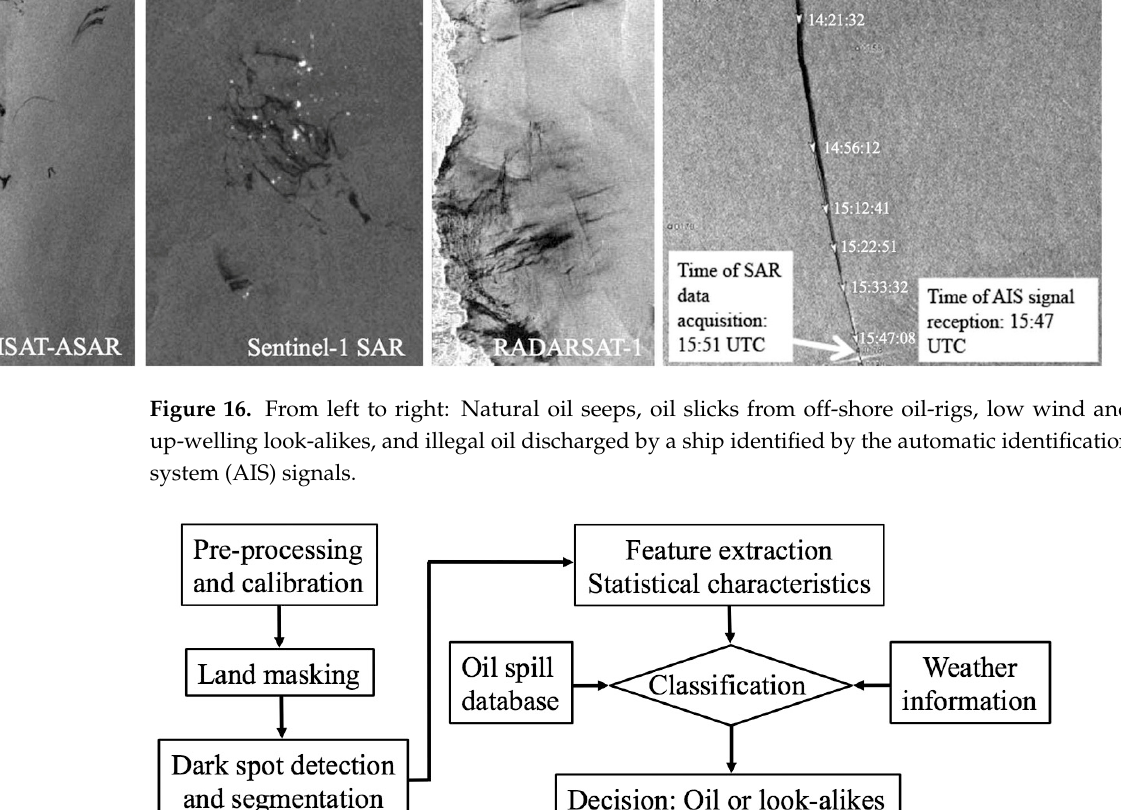
Figure 16. From left to right: Natural oil seeps, oil slicks from off–shore oil–rigs, low wind and up– welling look–alikes, and illegal oil discharged by a ship identified by the automatic identification system (AIS) signals.